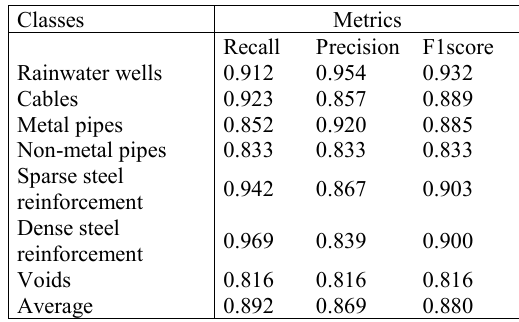
Table 3. Evaluation of the GPR image data target detection result The experimental results show that all three evaluate indices, the average values of recall, precision and F1 Score of the deep learning method designed in this paper are over 85%. The comprehensive evaluation of the three indicators indicates that the method here is very effective for the detection of underground targets and defects in GPR